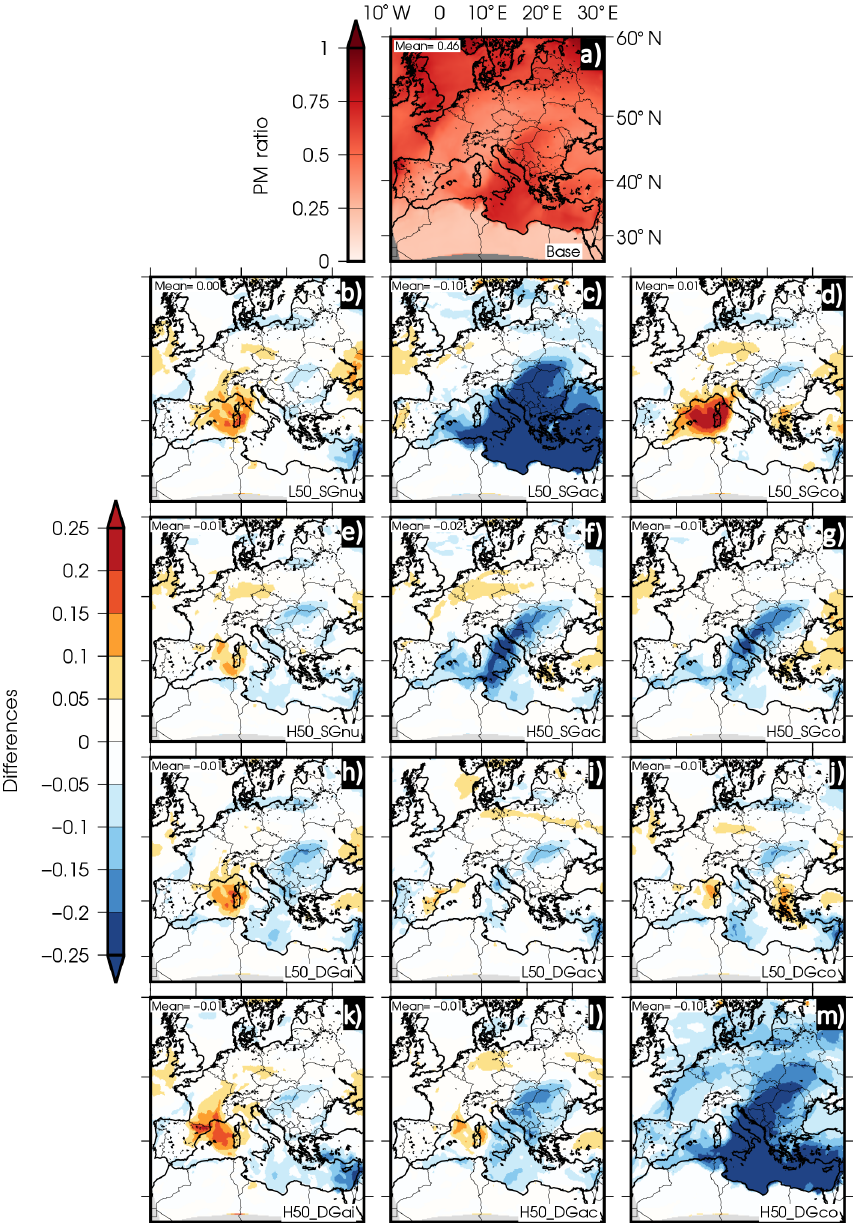
Figure 4. PM ratio at 1000hPa for the base case and differences for sensitivity simulations at 50%. (a) Base case; (b) Aitken-mode 50% reduction in SG; (c) accumulation-mode 50% reduction in SG; (d) coarse-mode 50% reduction in SG; (e) Aitken-mode 50% increase in SG; (f) accumulation-mode 50% increase in SG; (g) coarse-mode 50% increase in SG; (h) Aitken-mode 50% reduction in DG; (i) accumulation- mode 50% reduction in DG; (j) coarse-mode 50% reduction in DG; (k) Aitken-mode 50% increase in DG; (l) accumulation-mode 50% increase in DG; (m) coarse-mode 50% increase in